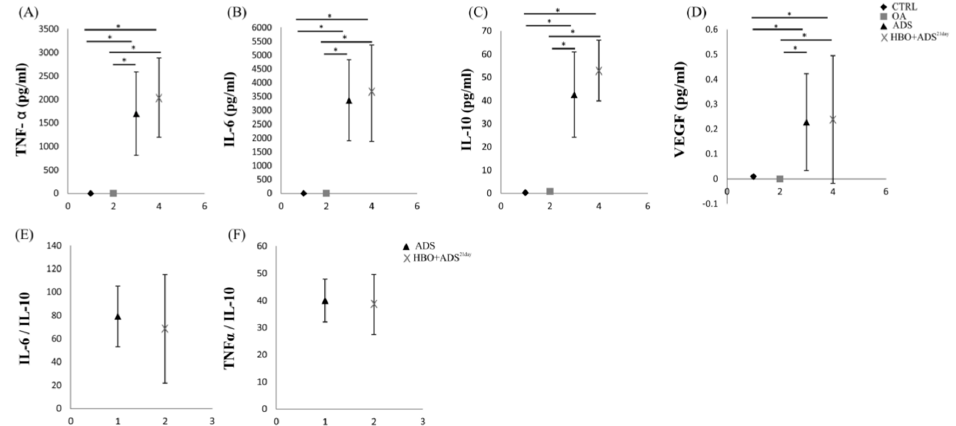
Figure 6. Changes in cytokine serum levels measured as ( A ) TNF- α , ( B ) IL-6, ( C ) IL-10 and ( D ) VEGF between CTRL, OA, ADS and HBO+ADS 21days groups. Changes in ( E ) IL-6/IL-10 ratio and ( F ) TNF- α /IL-10 ratio between ADS and HBO+ADS 21day groups. * p < 0.05 indicates statistical significant differences between groups.